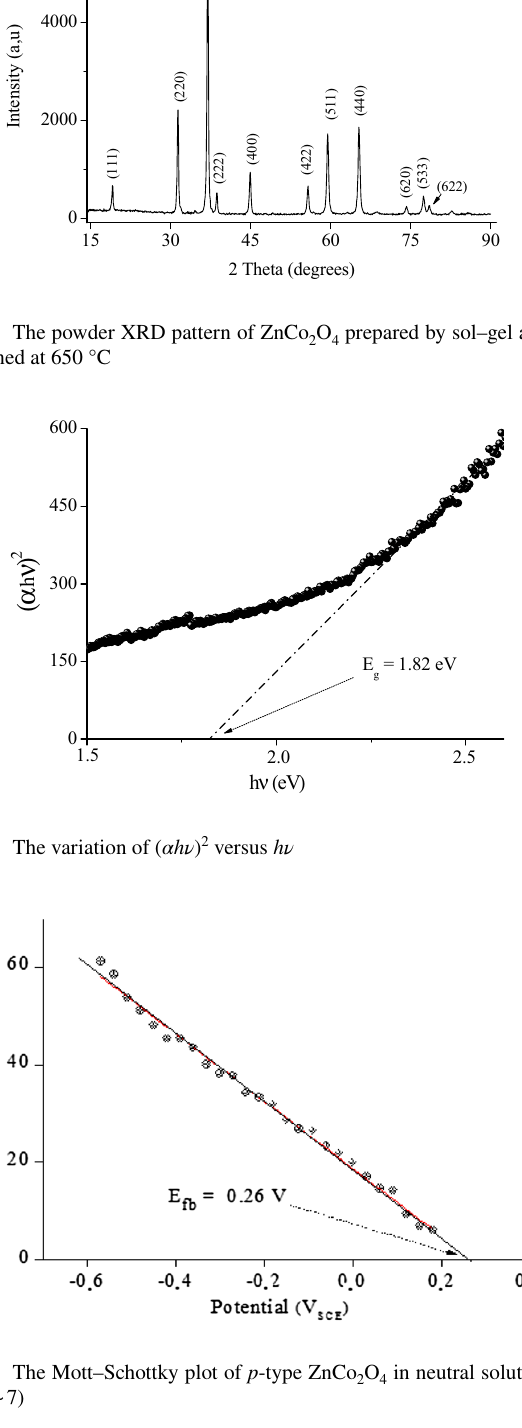
2 O 4 in neutral